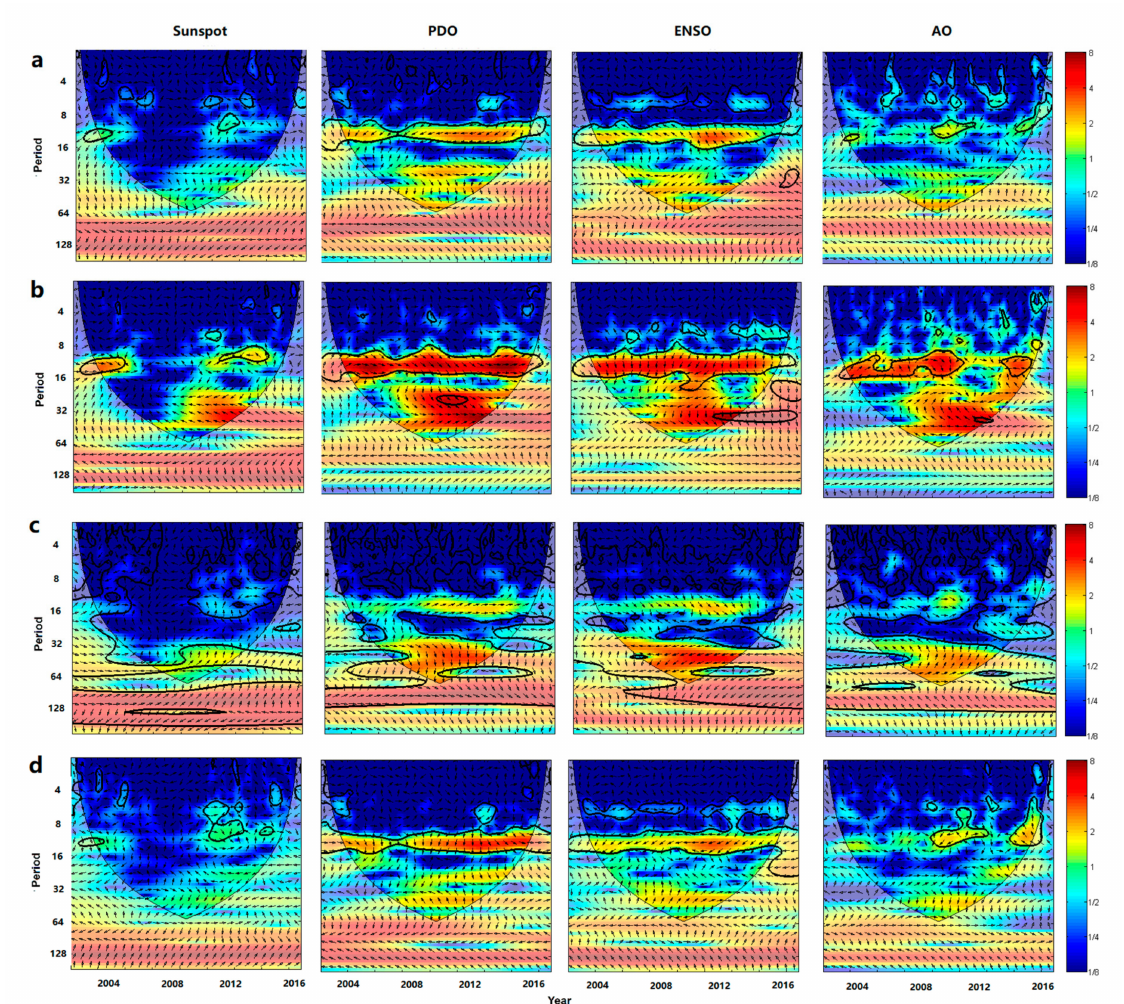
Figure8. Thecross-wavelettransformsbetweenterrestrialwaterstorageandtheatmosphericcirculation index as well as sunspots in the monthly time series. ( a ) North China; ( b ) South China; ( c ) Tianshan Mountains; ( d ) the Interior of the Tibetan Plateau. PDO, ENSO, and AO are abbreviations for Niño 3.4, Arctic Oscillation and Pacific Decadal Oscillation, respectively. In the cross-wavelet graph, the redder the color indicates the stronger the correlation, but bluer indicates a weaker correlation. The thin black line is the boundary of the wavelet influence cone line and is the e ff ective spectral value area. The thick black line is the 95% confidence interval of significance level at the 5% significance